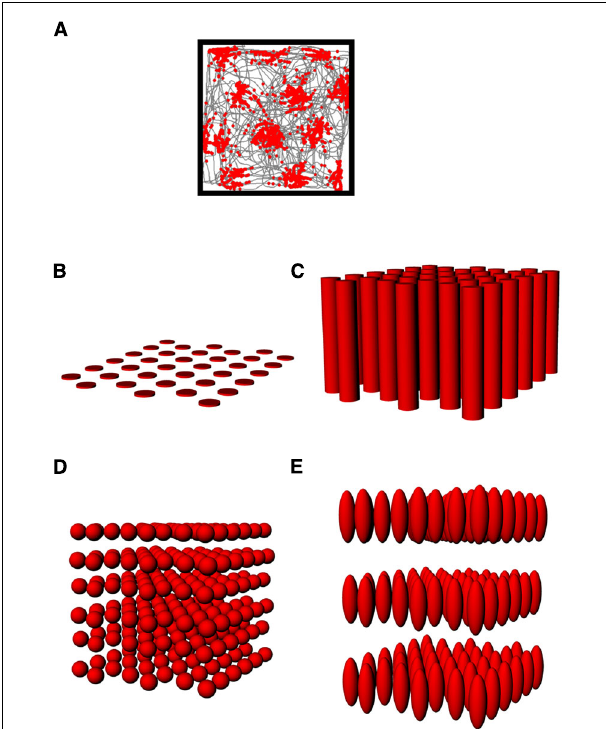
FIGURE 5 | (A) The firing pattern of an entorhinal grid cell (same depiction as in Figure 2A), showing the multiple evenly-spaced fields typical of these neurons. (B–E) Hypothetical structure of grid fields in 3D space. (B) The grid might be flat, with no activity in the vertical space above the floor; (C) The fields might be distributed in 3D space but only show spatial structure in the horizontal plane; (D) The fields might be symmetric in shape and be distributed throughout the volume in a close-packed array; (E) The fields might be distributed volumetrically, but in an anisotropic way (different scale in the vertical dimension).